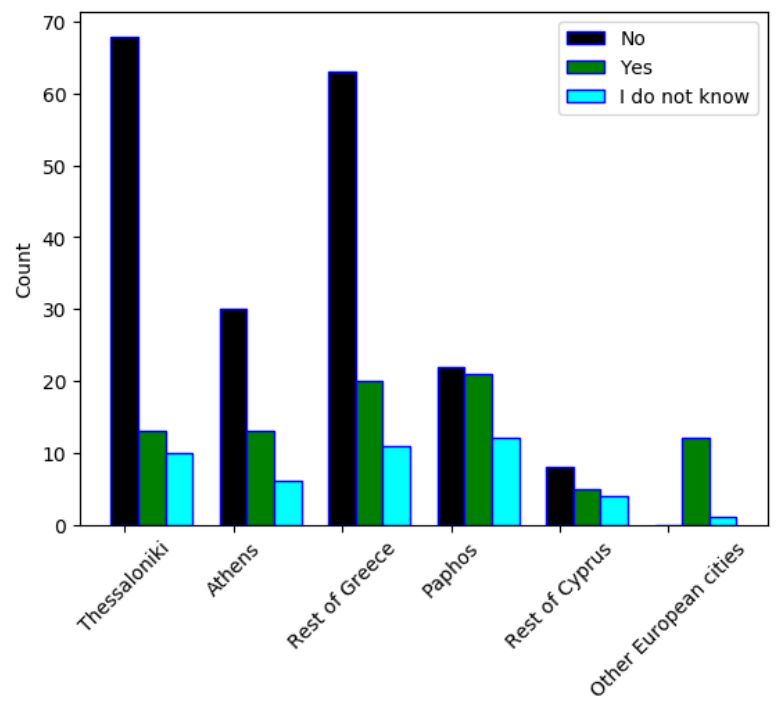
Figure 6. Participant’s belief for actions transforming their city into a smart